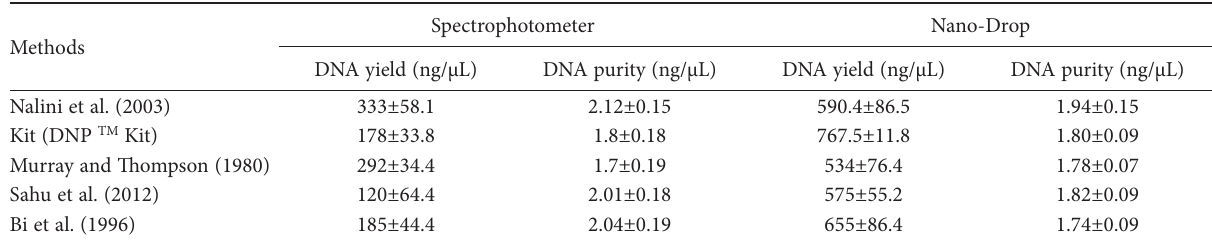
Table 3. Comparison of means for efficiency of three different DNA extraction methods in leaf samples of leaves Tamarix using Duncan’s multiple range test (P ≤